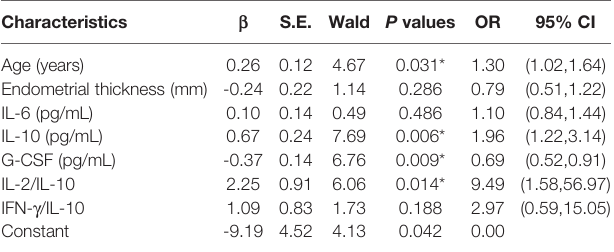
TABLE 5 | Logistic regression analysis of RIF risk prediction. Characteristics